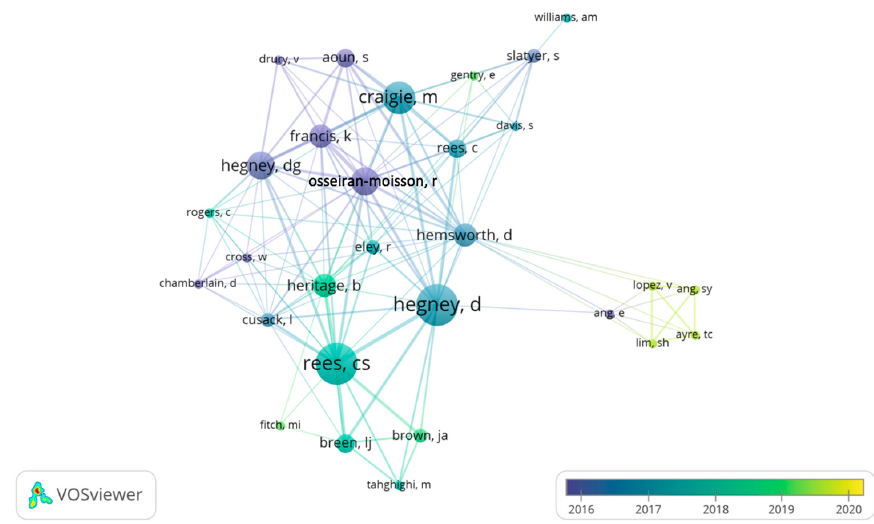
Figure 4. Top 10 authors with highest number of published articles.